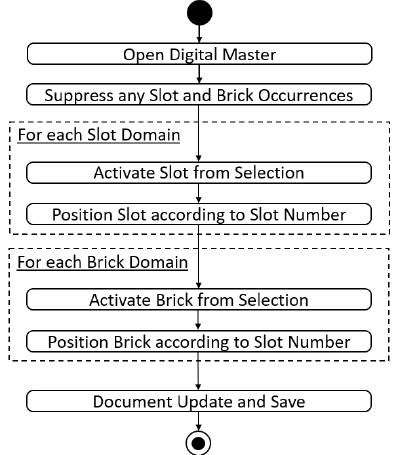
Figure 13. Activity diagram for CAD model update.